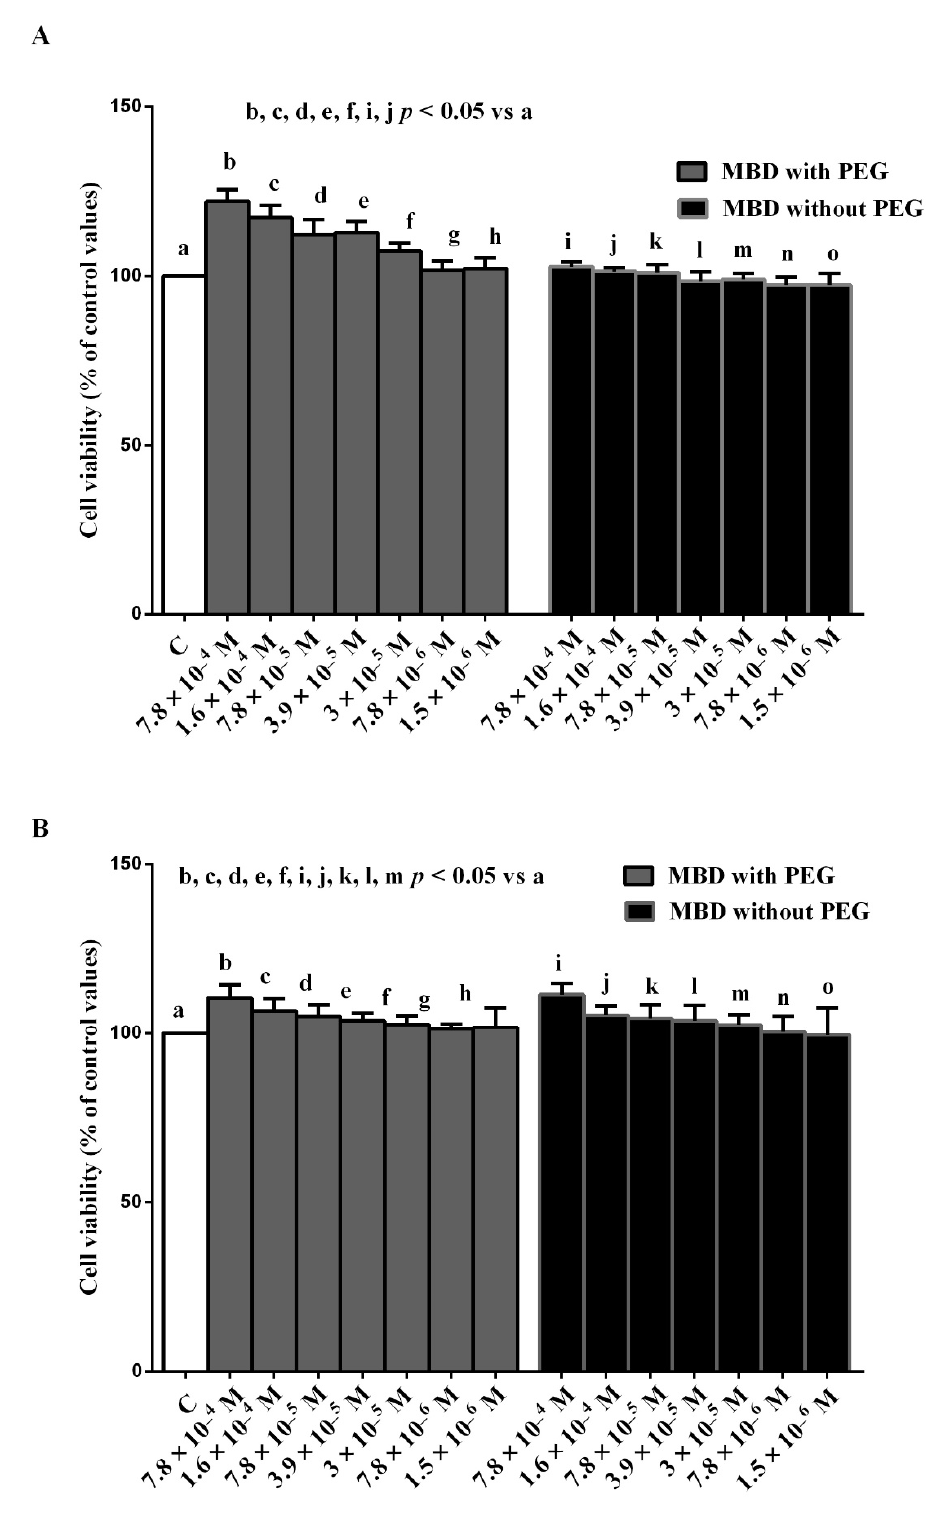
Figure 2. Dose–response effects of 30 min MBD with/without PEG on ARPE-19 cells ( A ) and RGC-5 cells ( B ). The results are means ± SD of repeated experiments. C: control cells (non-treated).